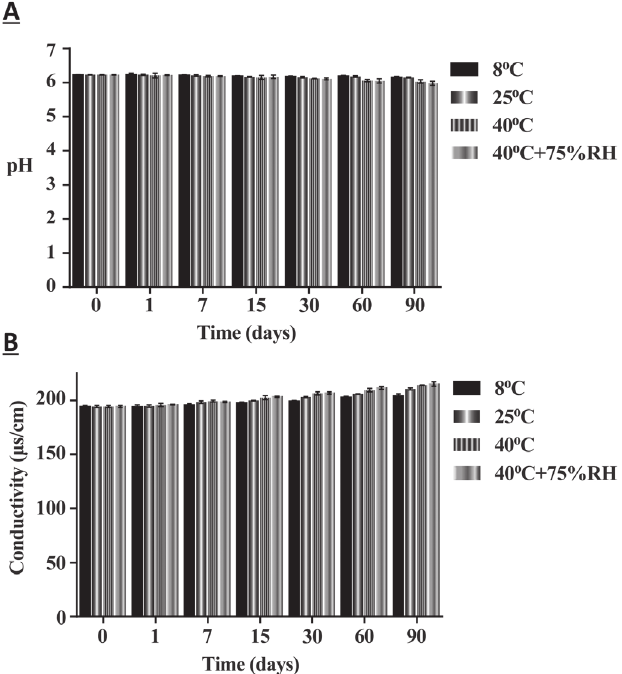
FIGURE 3 - (A) pH values of CT emulgel samples kept at 8 °C, 25 °C, 40 °C and 40 °C ±75% RH for 90-days, (B) electrical conductivity of CT emulgel samples kept 8 °C, 25 °C, 40 °C and 40 °C ±75% RH for 90-days.